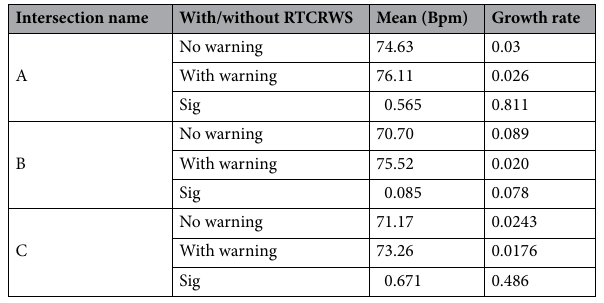
Table 2. Comparison of HR and growth rate. Sig . significance level of